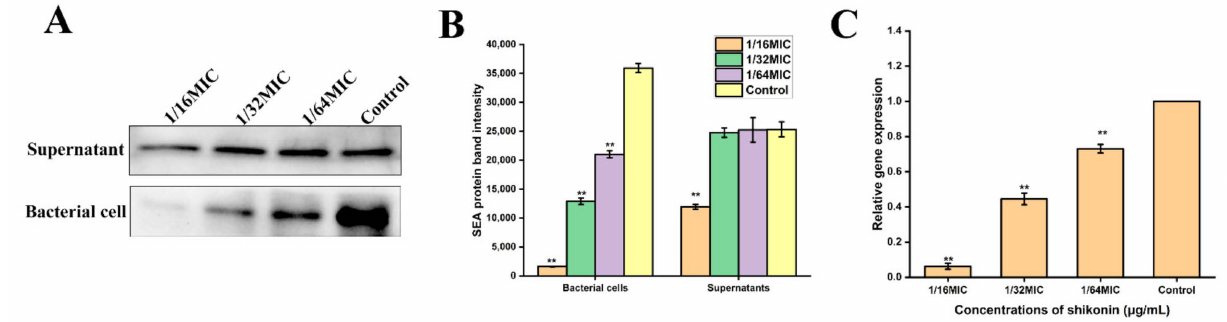
Figure 9. Non-inhibitory concentration of shikonin inhibited S. aureus sea gene expression. ( A , B ) Western Blot and densitometry detected the protein expression of SEA; ( C ) RT-qPCR detected the gene transcription of sea . ** p <